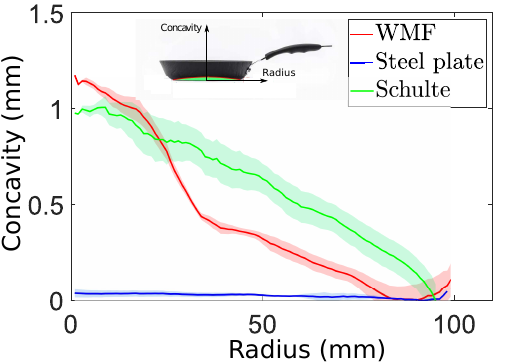
Figure 2. The mean and deviation concavity for each solid under investigation are depicted. The red line corresponds to the WMF, the green line to the Schulte and the blue line to the steel plate. The axis x = 0 is placed at the lowest geometric point of the vessel located in the